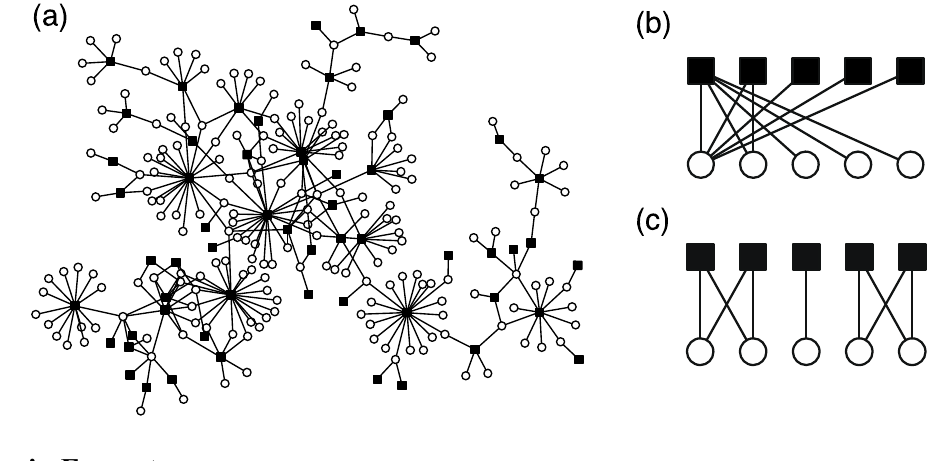
Figure 10. (a) The heterogeneous metabolite distribution (species–metabolite network) of Rutaceae (citrus family). Schematic diagram of the reconstruction of nested structure (b) and modular structure (c). The black squares and white circles correspond to species and metabolites,